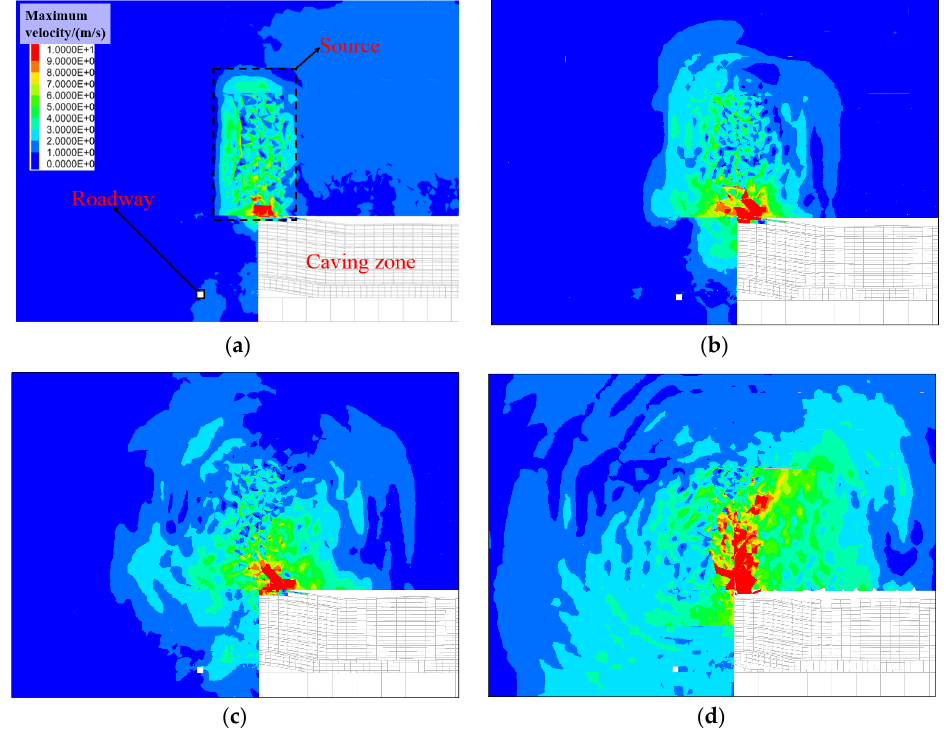
Figure 4. Velocity cloud diagram after mining ‐ induced tremor: ( a ) 10 ms; ( b ) 20 ms; ( c ) 30 ms; ( d ) 40 ms. From Figure 4, the velocity diffused outward in an arc from the four corners of the rec ‐ tangular source and gradually intersected into a circle with the increasing propagation dis ‐ tance, with a maximum velocity of 10 m/s. At 40 ms, the stress wave reached the roadway, resulting in the rapid increase in speed from 0 m/s to 2 m/s around the roadway. As shown in Figure 5, the kinetic energy rapidly reached the peak value of 7.5 × 10 6 J within 10 ms, and then begins to decrease gradually. At 106 ms, the stress wave excited by the source transmit ‐ ted to the roadway, and the kinetic energy of the roadway began to increase and reach a peak of 3.1×10 4 J at 148 ms. Then, under the effect of damping, the kinetic energy of the roadway gradually decreased to 0. Obviously, the propagation disturbance of the tremor input a large amount of kinetic energy to the roadway. Under the strong disturbance of the tremor, the stress of the surrounding rock of the roadway was sharply adjusted, resulting in a gradual increase in the vibration speed. Finally, the surrounding rock was ruptured sud ‐ denly. The maximum vibration speed reaches approximately 10 m/s, and a rockburst was inevitably triggered. Figure 5. Kinetic energy curves of roadway and source after mining ‐ induced tremor. 2.3.2. Evolution of Stress, Displacement and Fracture The variations in maximum principal stress around the roadway due to the dis ‐ turbance of a mining ‐ induced tremor are shown in Figure 6.